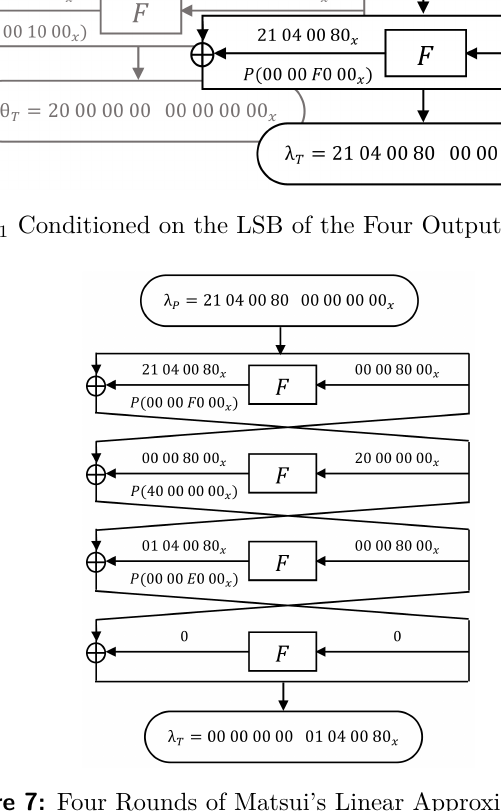
Figure 7: Four Rounds of Matsui’s Linear Approximation ( λ 2